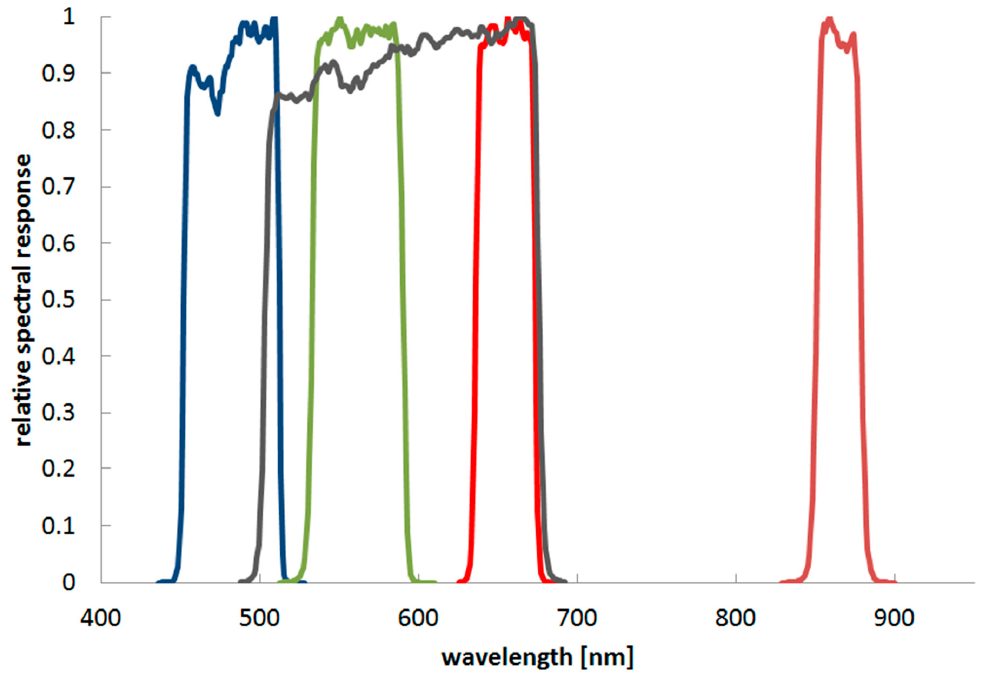
Figure 1. Landsat 8 spectral response functions for the blue, green, red, panchromatic ( black ) and near-infrared (NIR) ( dark orange ) bands. near-infrared (NIR) ( dark orange )